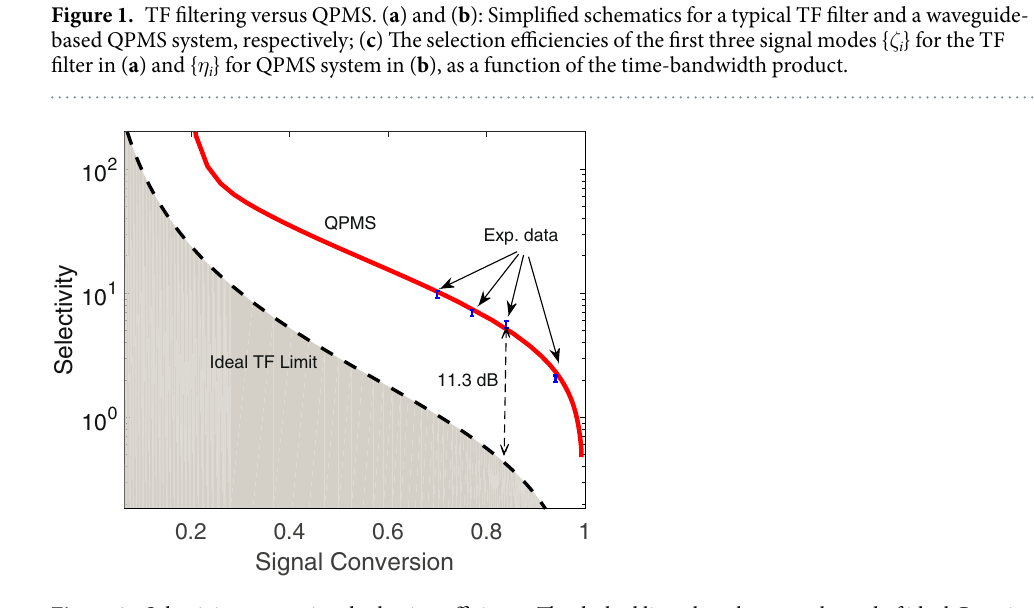
Figure 2. Selectivity versus signal selection efficiency. The dashed line plots the upper bound of ideal Gaussian TF filters, while the solid line shows the simulation results for a QPMS system with a Gaussian pump. The dots show our experimental result, as described in Section